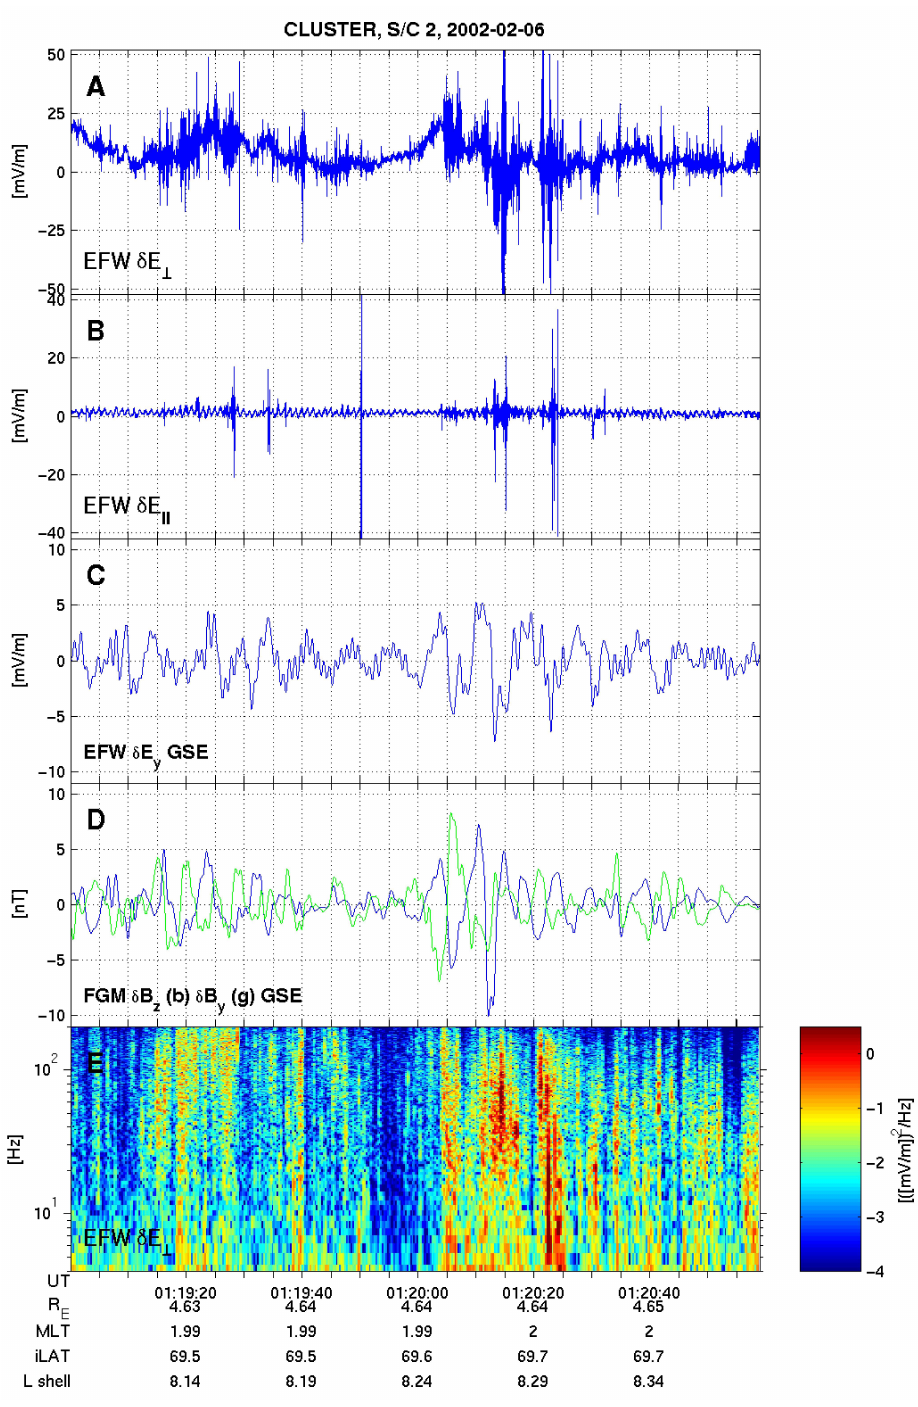
Fig. 1. Data from Cluster spacecraft 2 obtained during a crossing of the Northern Hemisphere auroral oval: electric field (0.1–180Hz) perpendicular (panel A ) and parallel (B) to the geomagnetic field; perpendicular electric field (0.1–1Hz) approximately in the GSE y- direction (C) ; magnetic field (0.1–1Hz) in GSE y- (green) and z-directions (blue) (D) ; spectra of the perpendicular electric field (E) . Several bursts of broad-band waves are observed, often but not always with a dominating perpendicular electric field, and often occurring in the same regions as low frequency